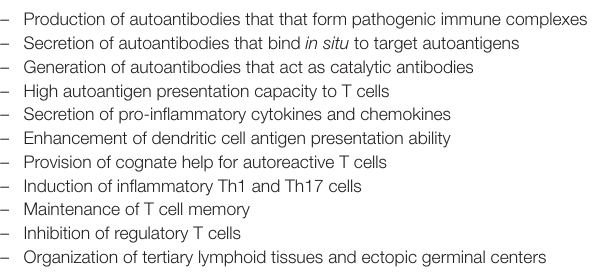
TABLe 1 | Antibody-dependent and independent roles of B cells in autoimmune disorders.